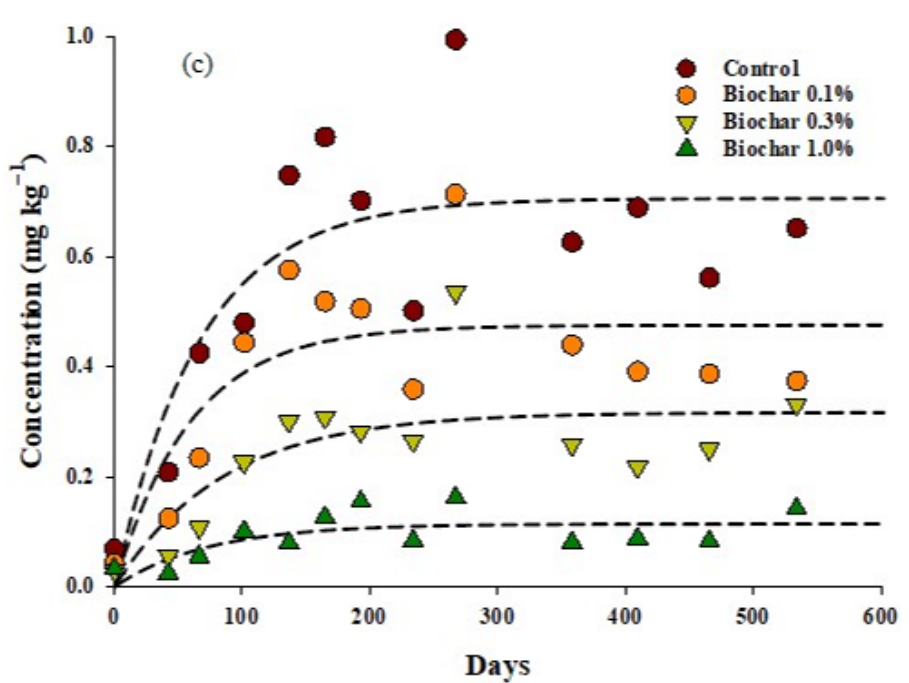
Figure 4. Comparison of the residues of endosulfan over time for the different components tested in this study: ( a ) α endosulfan, ( b ) β endosulfan, ( c ) endosulfan sulfate.